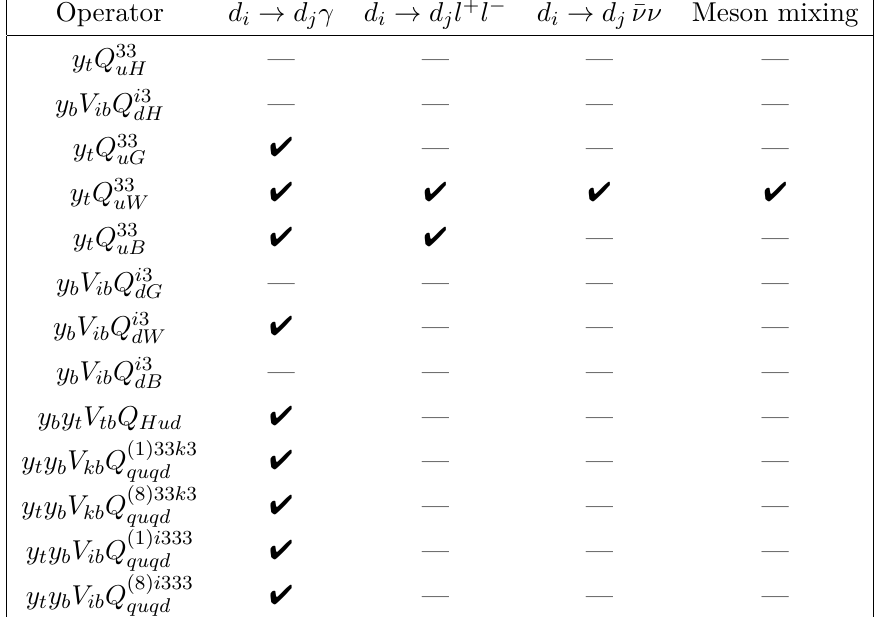
Table 2. All operators which are brought into flavour symmetric form with insertions of y t and/or y b . Tick marks indicate that the operator in that row contributes to the flavour-violating process of interest in that